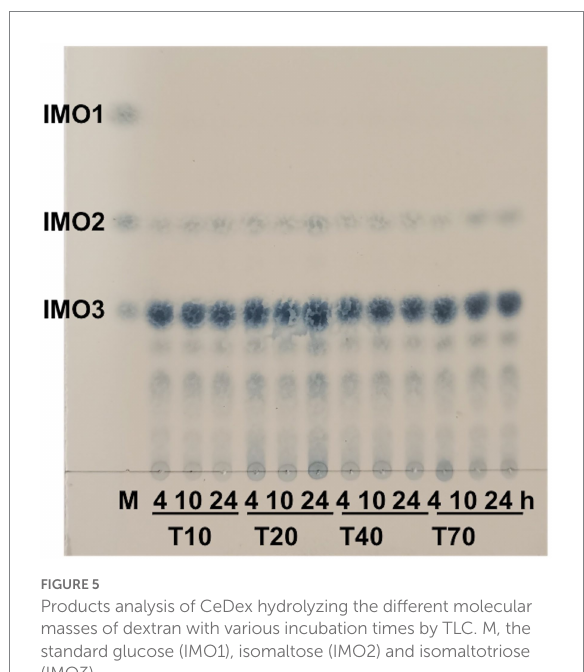
FIGURE 5 Products analysis of CeDex hydrolyzing the different molecular masses of dextran with various incubation times by TLC. M, the standard glucose (IMO1), isomaltose (IMO2) and isomaltotriose